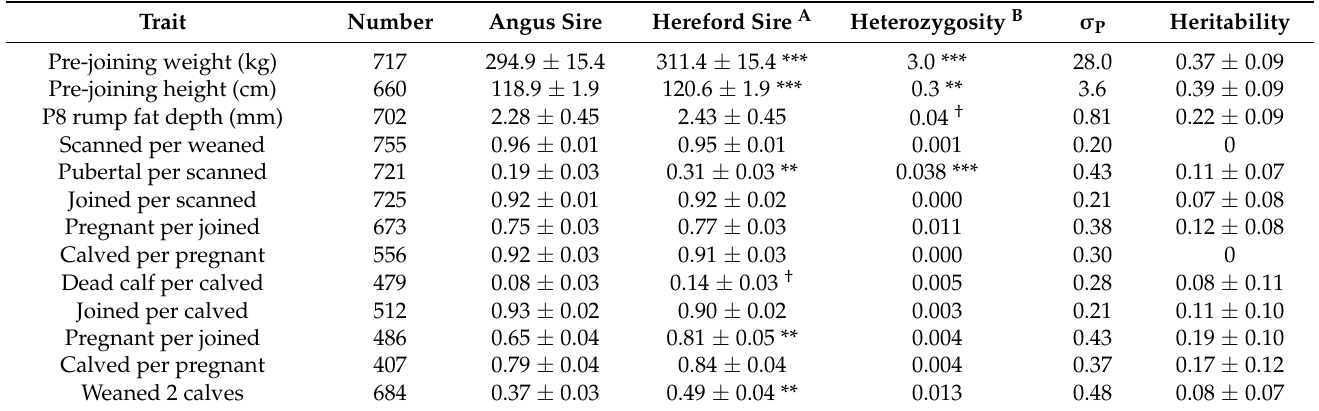
Table 1. Number of measurements, sire breed means from fixed effects model, heterozygosity, phenotypic standard deviation ( σ P ), and heritability estimates from the genomic model. All traits except weight, height, and fat are binary (0 = no and 1 =